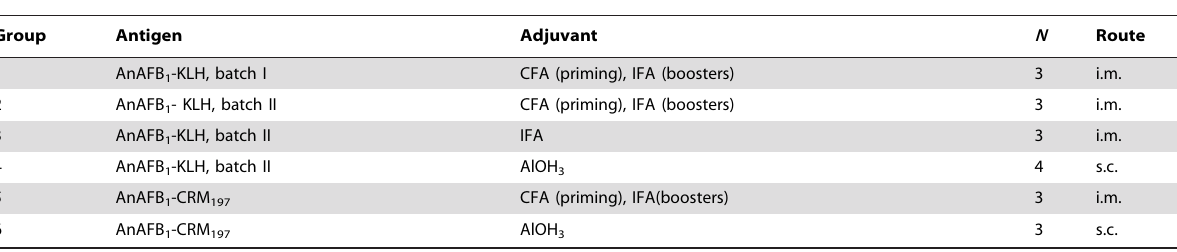
Table 1. Immunization